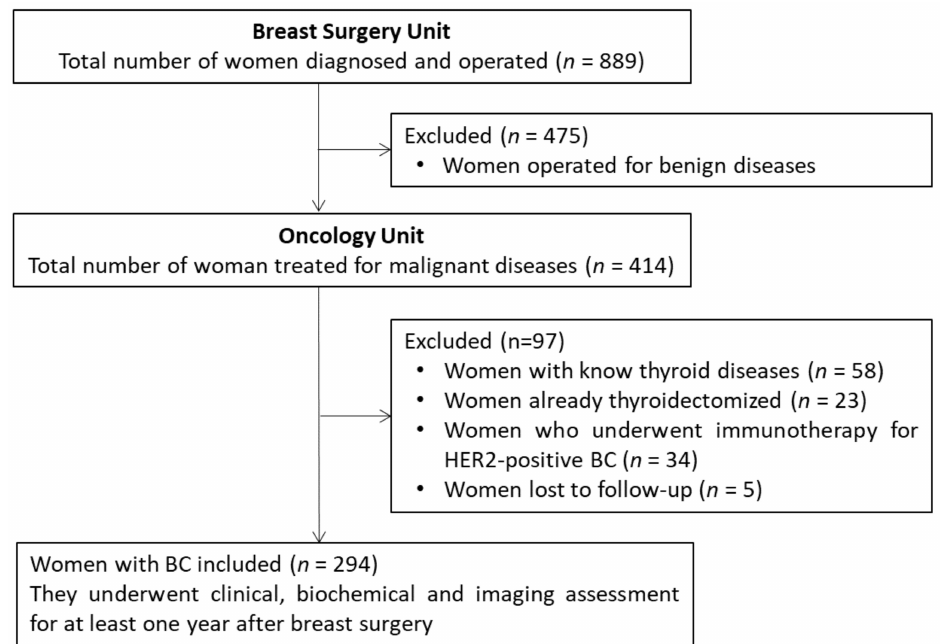
Figure 1. Flow chart of patient